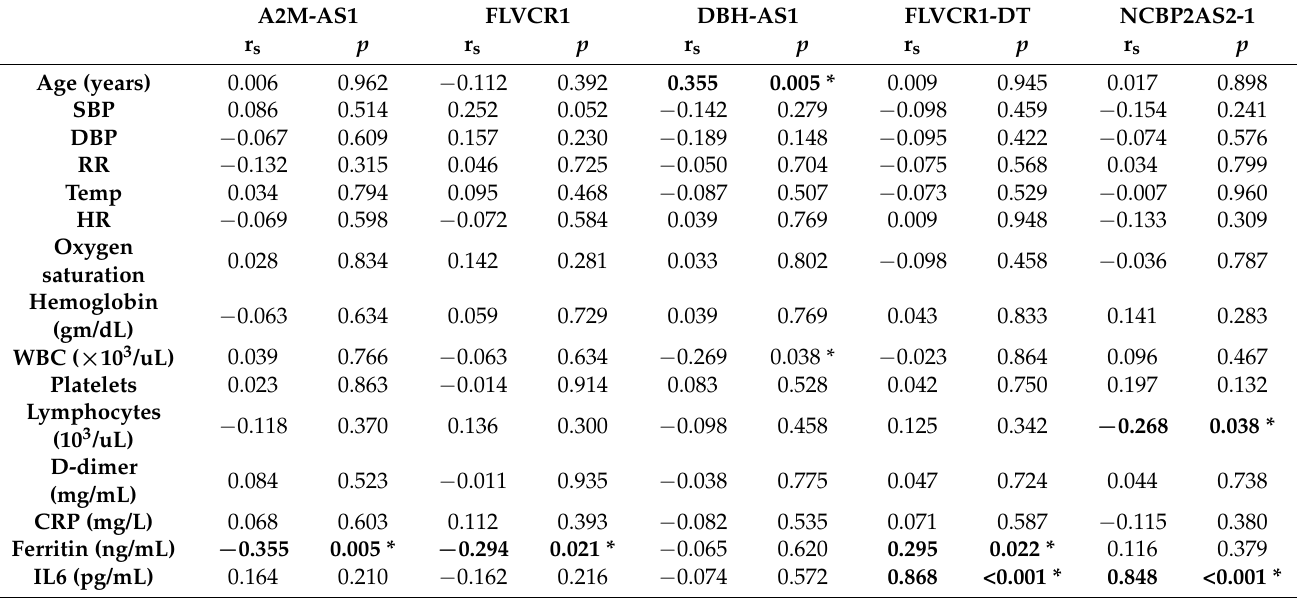
Table 4. Correlation between different parameters in group III ( n = 60).